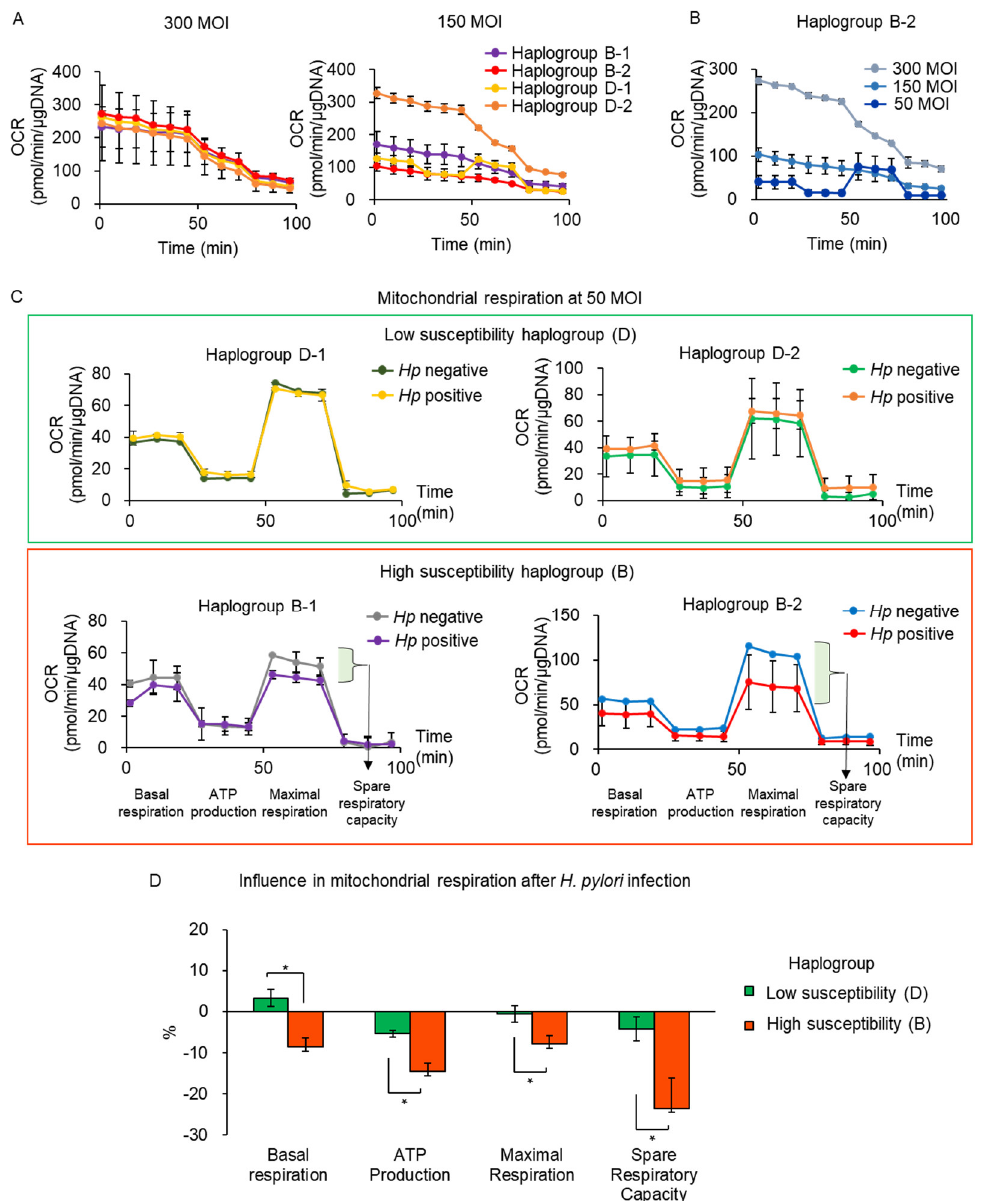
Figure 4. Decreased mitochondrial respiration in high-susceptibility haplogroup by H. pylori infection. ( A ) Abnormal assessment of mitochondrial respiration with high MOI of H. pylori infection using seahorse assay. ( B ) Comparison of mitochondrial respiration assessment upon infection with H. pylori of haplogroup B-2 with that of various MOI. H. pylori infection at low MOI (50) enabled normal assessment of mitochondrial respiration. ( C ) Mitochondrial respiration measurement upon H. pylori infection at 50 MOIs. OCR was decreased in the high-susceptibility haplogroup (higher frequency in the H. pylori -positive population than in the negative one) after H. pylori infection. Low-susceptibility haplogroup (lower frequency in the H. pylori -positive population) revealed similar OCR after H. pylori infection. ( D ) Influence of H. pylori infection on mitochondrial respiration. Mitochondrial respiration was significantly decreased in high-susceptibility haplogroup after H. pylori infection than in that of low-susceptibility haplogroup (* p < 0.05). Error bars indicate mean ± SD (A, B, and C) or mean ± SEM (D).